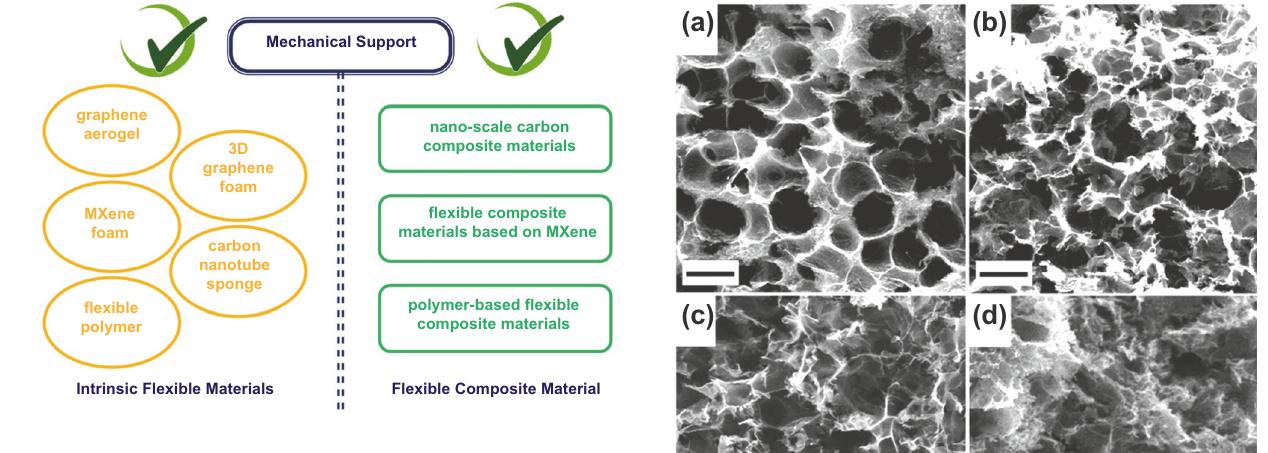
Fig. 2 Classification of flexible EMI shielding materials